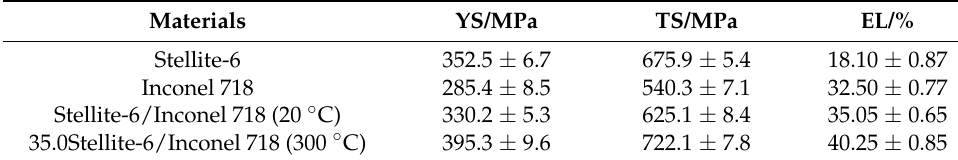
Figure 11. Tensile properties of Stellite-6/Inconel 718 FGM: ( a ) yield strength; ( b ) tensile strength; ( c ) elongation. Table 2. Tensile properties of single material and FGM material.